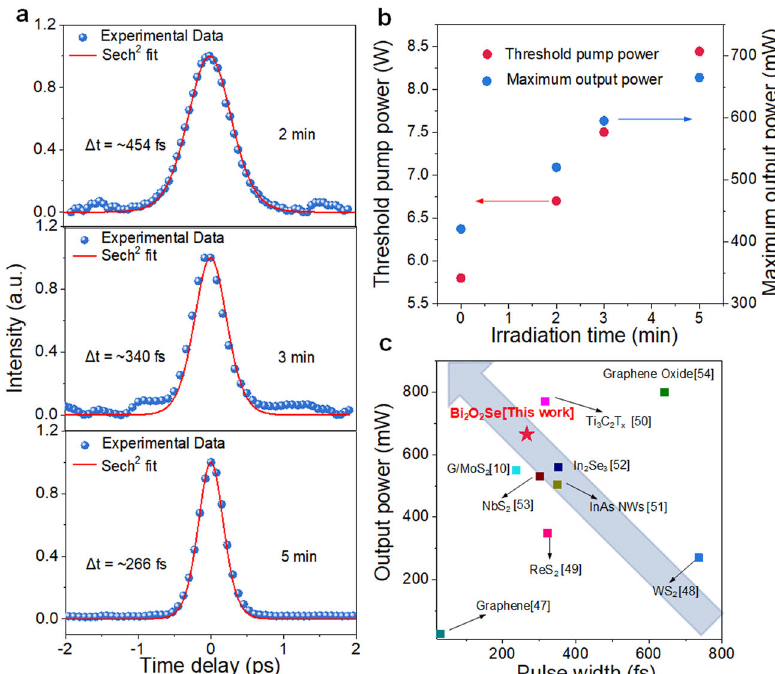
Fig. 4 Mode-locked laser results based on Bi 2 O 2 Se nanoplates under different plasma irradiation times. a Autocorrelation trace under different plasma irradiation times. b Trend of the maximum average output power and threshold pump power of the CWML based on Bi 2 O 2 Se SA treated with different argon plasma irradiation times. c Results of mode-locked solid-state bulk lasers operating at 1.0 µ m based on various